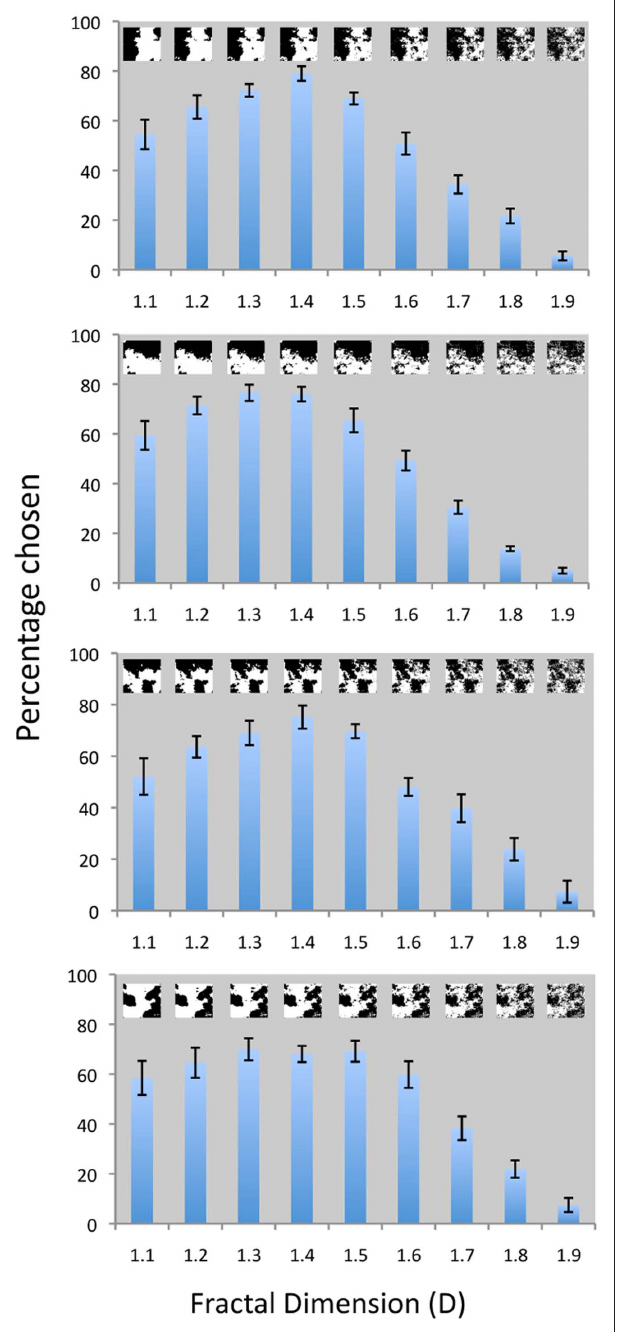
FiGurE 8 | Visual preference for computer-generated fractals: The vertical axis in each panel corresponds to the percentage of trails for which patterns of a given D value were chosen as a function of fractal dimension ( D ). Each of the four different panels uses a different fractal configuration to investigate this visual preference. The fractal images are shown as insets in each panel. The main effect of fractal dimension ( D ) on visual preference was significant for all four types of fractal images: F = 22.16, p < 0.0001; F = 38.01, p < 0.0001; F = 15.68, 8,19 8,19 8,19 p < 0.0001; and F = 1.54, p < 0.0001 from the top to the bottom panel 8,19